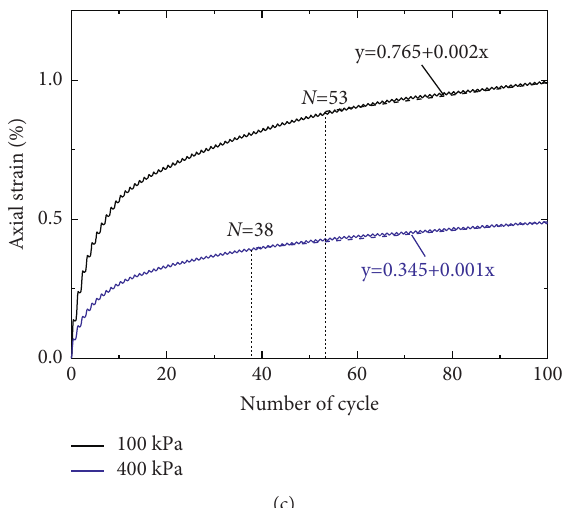
Figure 9: Curve axial strain versus number of cycles at different confining stresses under N � 100. (a) T � 10 s; (b) T � 60s; (c) T � 90s.